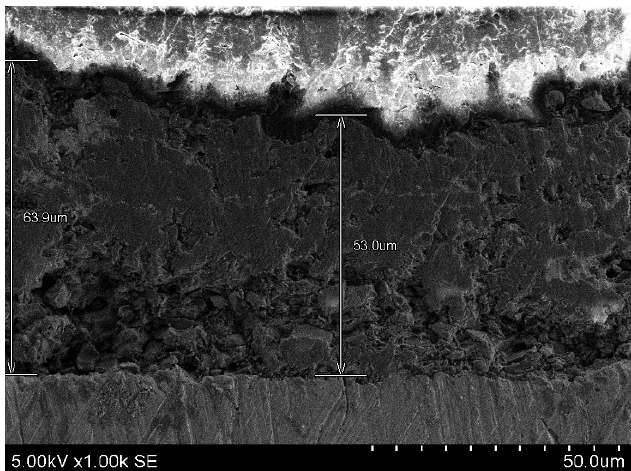
Figure 3. SEM cross-section image of Al 2 O 3 coating.